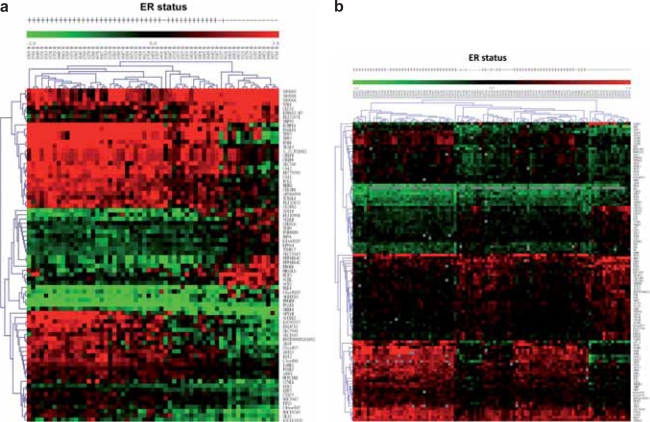
Hierarchical clustering diagrams of (a) NTUH dataset and (b) NCI dataset. Genes with similar expression pattern (vertical) and breast cancer samples with similar ER statuses (horizontal) were hierarchically clustered together. For the NTUH dataset, the majority of ER+ samples are on the left region (from 1595 M to 1257 M, except for 1431 M and 1587 M) while the majority of ER− are on the right; for the NCI dataset, few ER− samples fell under the ER+ group (X 21643 and X21618), as most ER− samples were clustered in the middle or on the right The clustering results confirmed our selection of differentially expressed genes in ER+/ER− groups, representing distinct gene expressions between NTUH and NCI datasets.